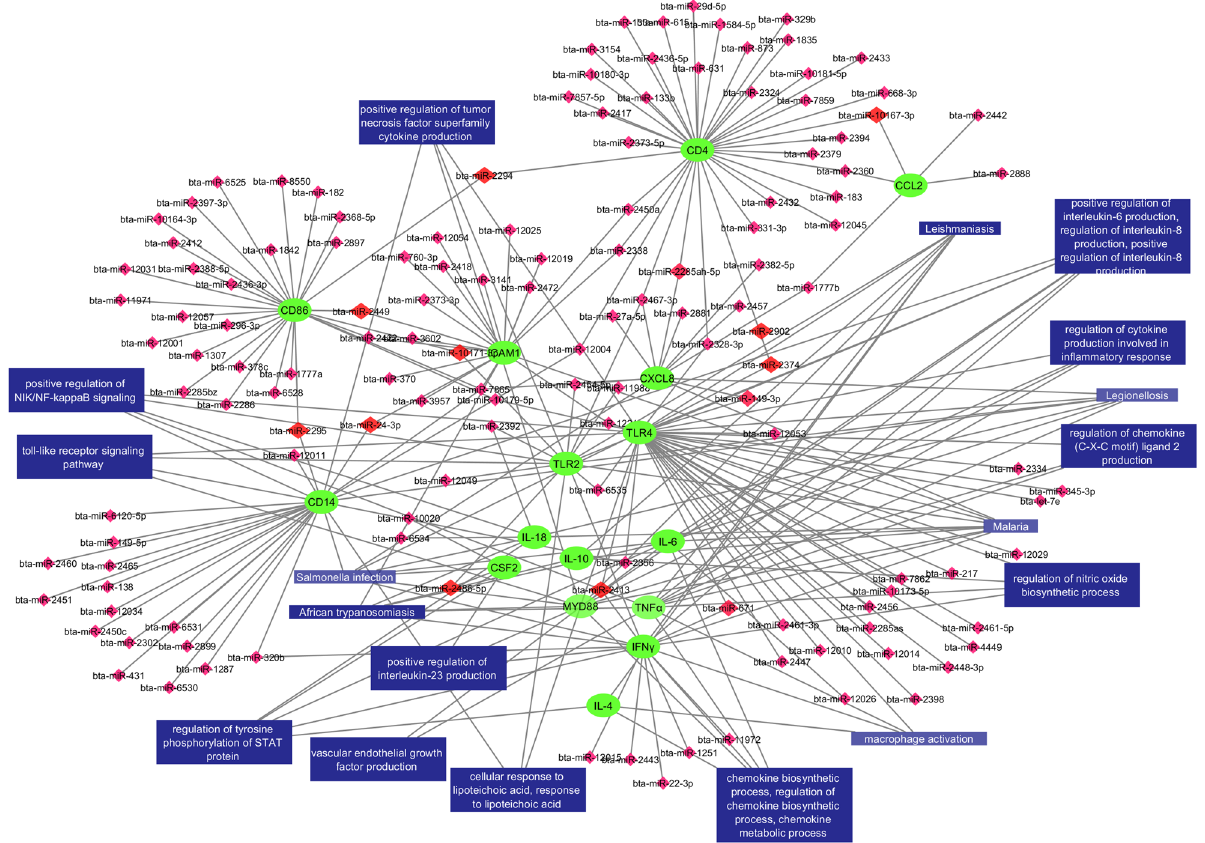
Figure 8. Network interactome of miRNA, their target genes, and the gene ontologies of the target genes. The pink diamonds are miRNA binding to a single target gene while the red diamonds are miRNA binding to two or more target genes. The green circles are the 16 target genes and the blue rectangles are the biological processes, molecular functions, cellular components, and pathways. (Cytoscape version 3.7.2; https:// cytos cape.